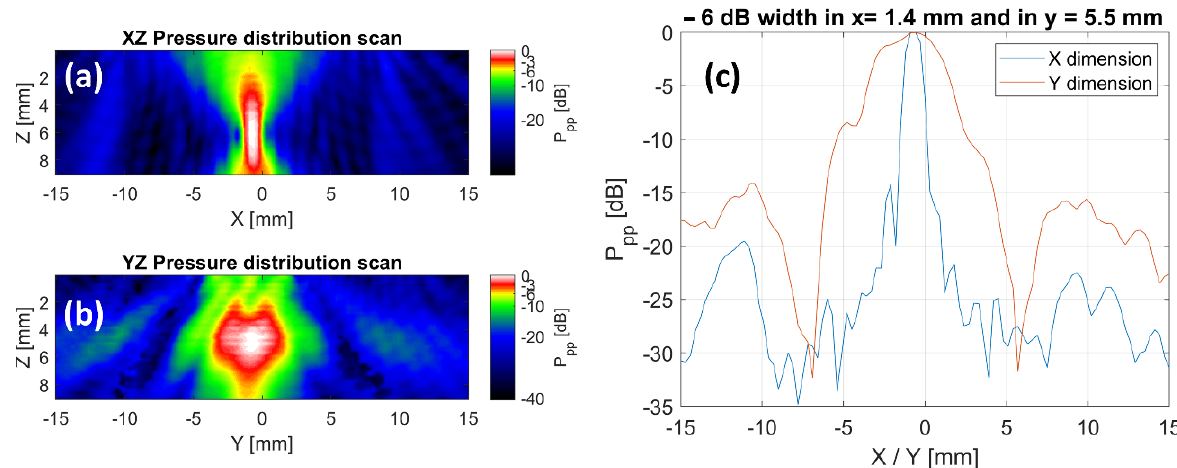
Figure 2. Assessment of the single-transducer pressure distribution in 2D and 1D. ( a ) and ( b ) show two 2D sound fields (Peak-to-Peak pressure in dB is plotted) acquired in a water tank measurement to assess the extent of the focal area. ( c ) Shows a lateral cross-section through the depth of highest pressure.